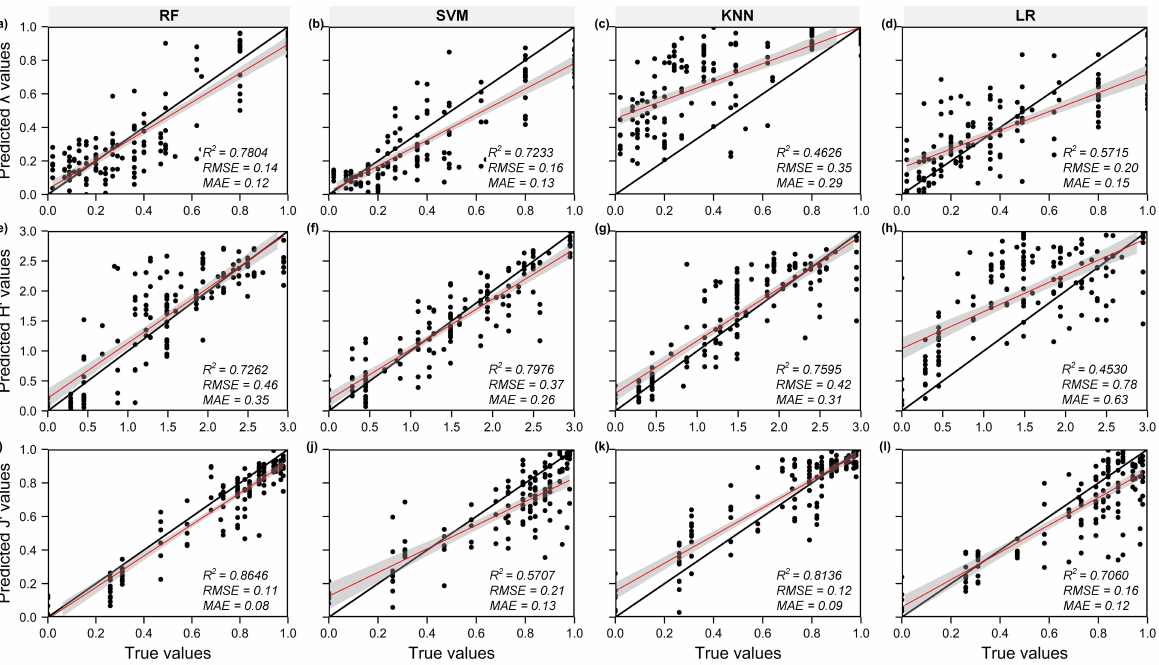
Figure 3. Scatterplot matrix of true values and predicted values by using RF, SVM, KNN, and LR models in three diversity indices. Shannon indices ( a – d ), Simpson ( e – h ), and Pielou ( i – j ). **: Significant correlation ( p < 0.01),